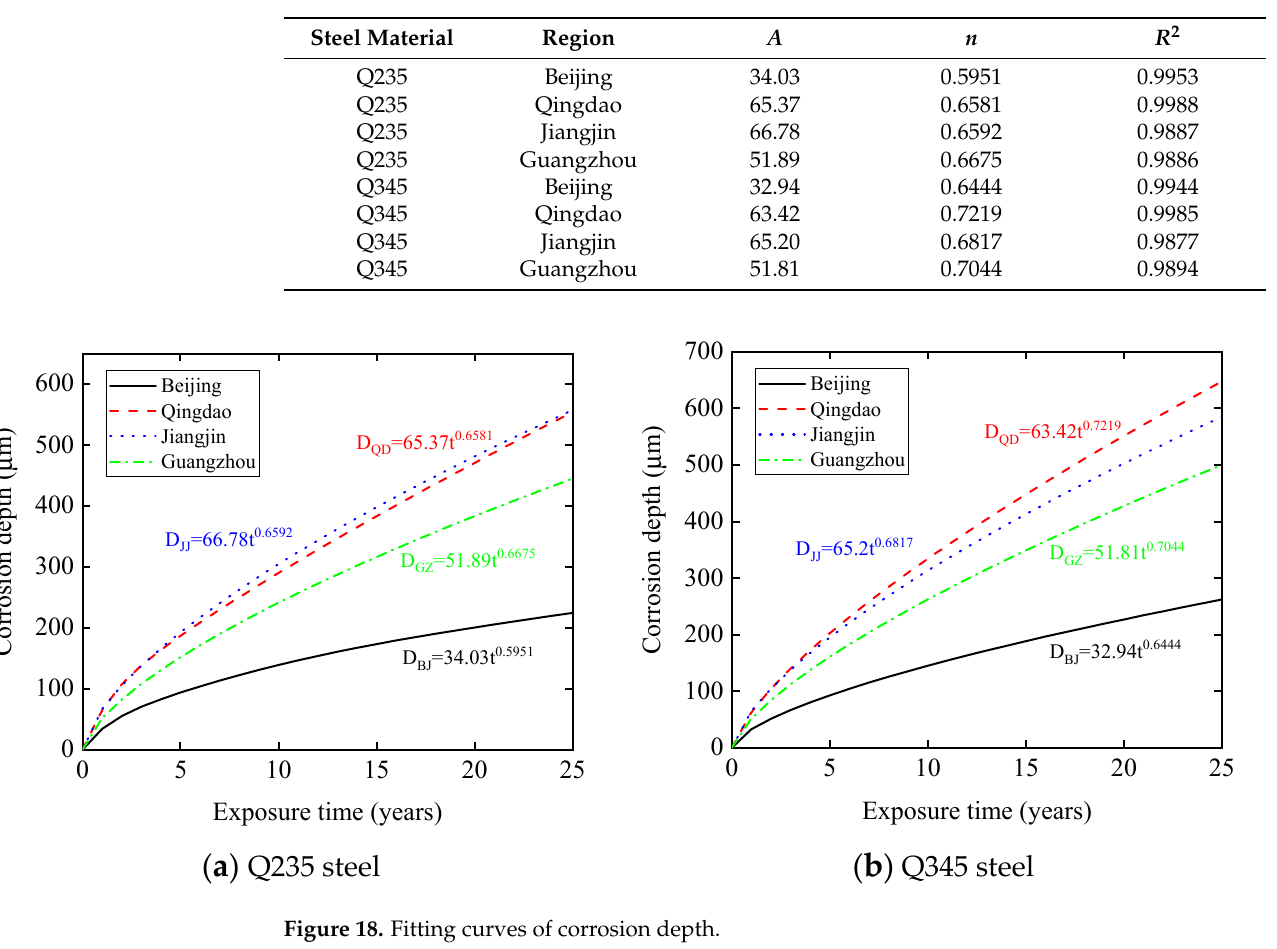
Table 7. Fitting results of corrosion depth prediction values.